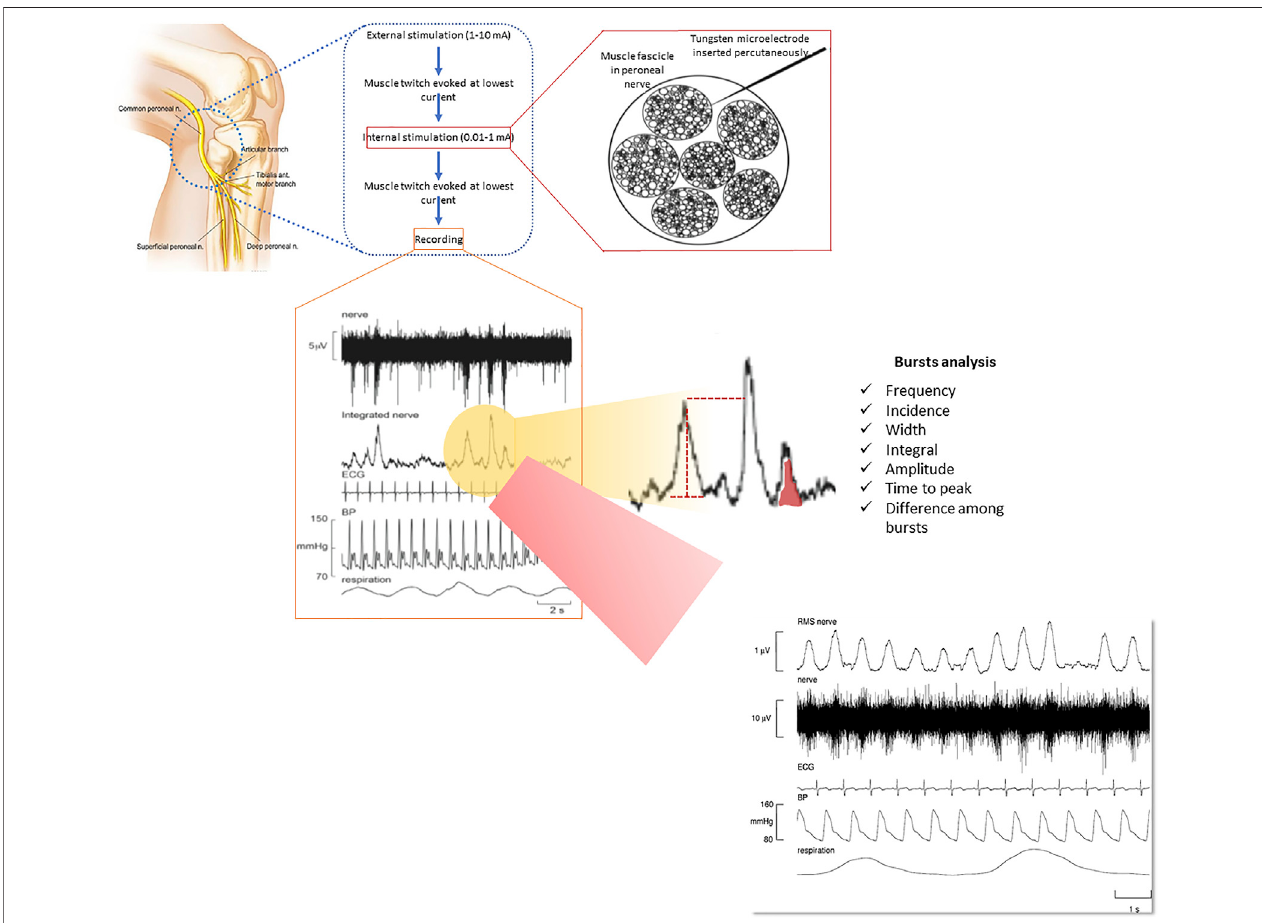
FIGURE 1 | Methodology of recording muscle sympathetic nerve activity (MSNA) through microneurography and its elevation in a patient with COPD. Reproduced, with permission, from Ashley et al. (2010). MSNA is measured via a tungsten microelectrode inserted percutaneously into a muscle fascicle of an accessible peripheral nerve. Various components of the bursts can be measured, providing a comprehensive assessment of muscle vasoconstrictor drive that is put into a broader context of other physiological signals, including heart rate, blood pressure and respiration (see lower part of the fi gure for representative